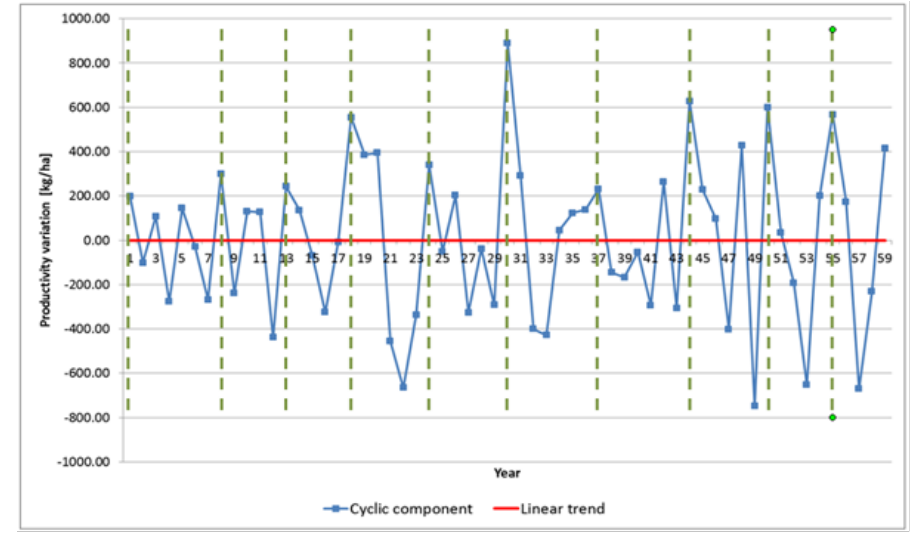
Figure 4. Cycles of variation of yield for grain in France. Source: authors own computation based on [56]. Step 2. Analysis of the Cyclical Component of Yield and Extraction of a Variation Pattern for